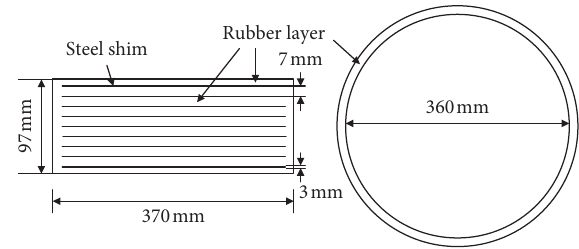
Figure 2: Configuration details of the bearing